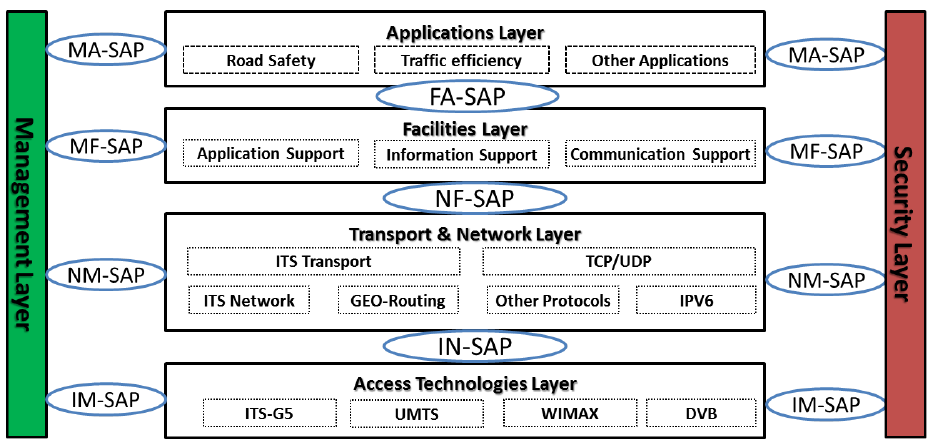
Figure 3. ETSI TC ITS reference architecture.